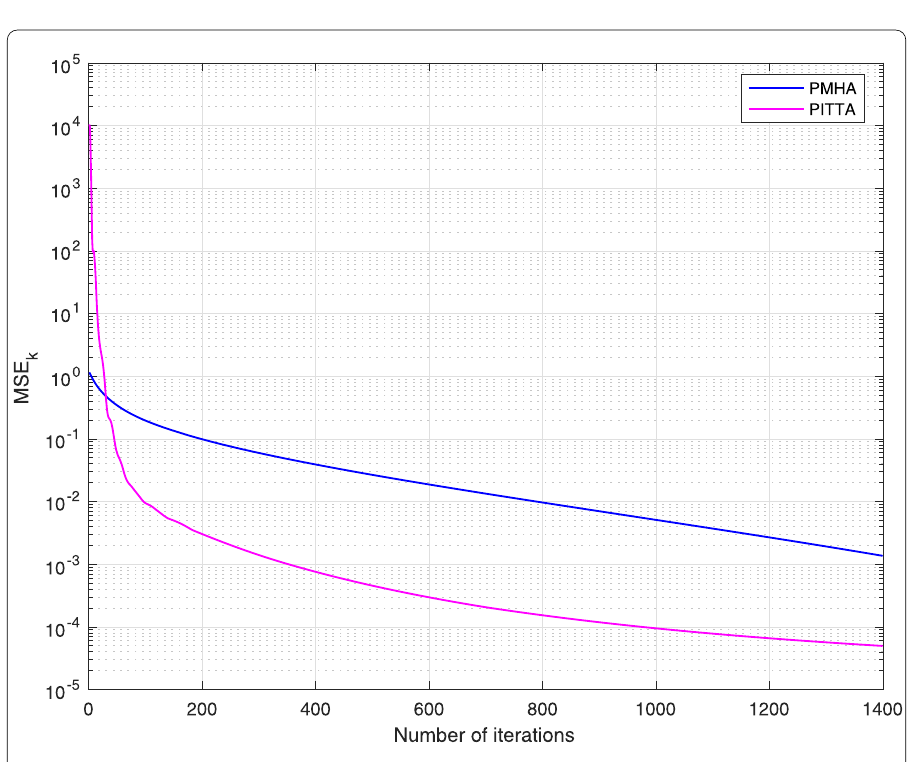
Figure 8 The mean-squared error versus the number of iterations for m = 128